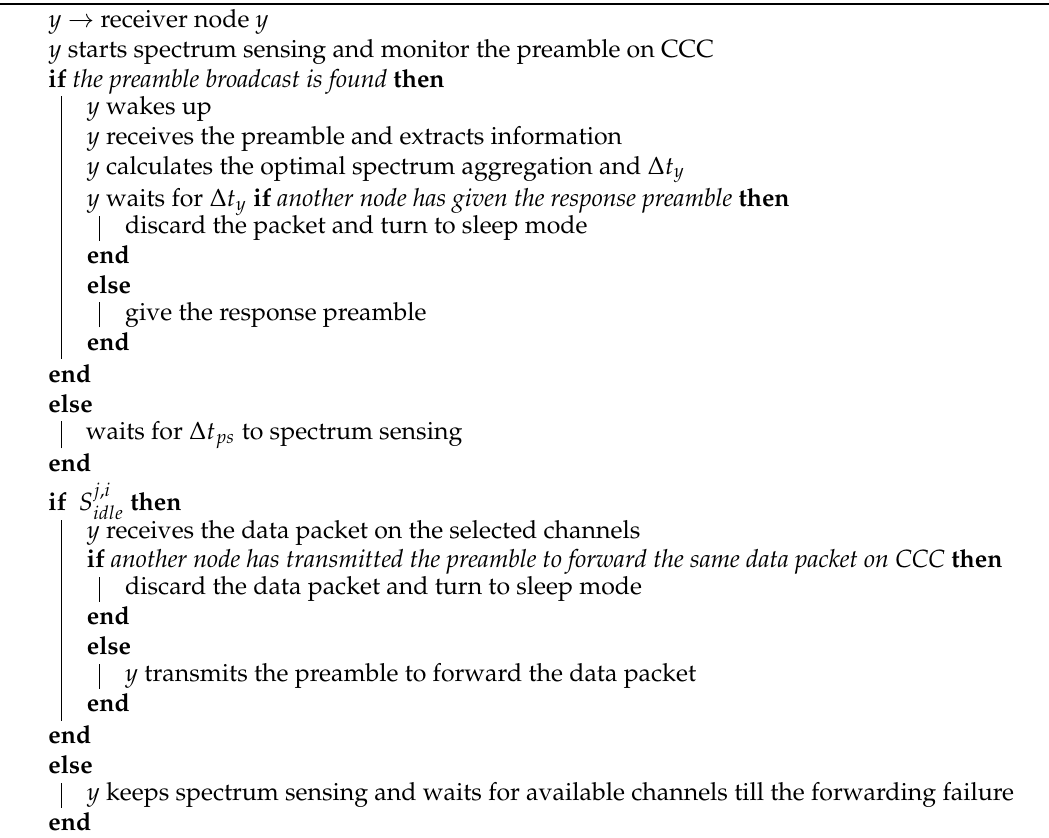
Algorithm 1: Response-based Forwarder Competition Mechanism y → receiver node